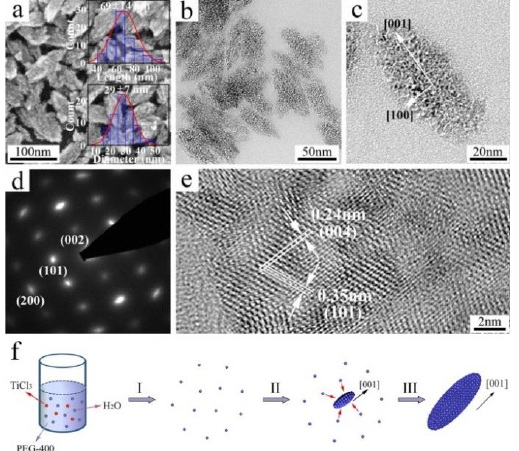
Figure 10. ( a ) SEM and ( b , c ) TEM images of anatase TiO 2 mesocrystals obtained via hydrolysis reaction of TiCl 3 in PEG-400. The insets in ( a ) are the related particle size distributions of the mesocrystals. ( d ) SAED pattern recorded on the anatase mesocrystal shown in ( c ); ( e ) HRTEM image of anatase mesocrystal; ( f ) A tentative mechanism for the formation of anatase mesocrystals. Reprinted with permission from [150]. Copyright American Chemical Society, 2017.